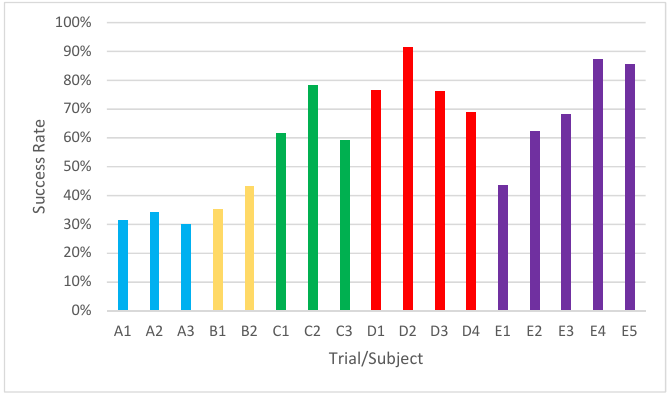
Figure 17. Percentage of success of each subject for each attempt.